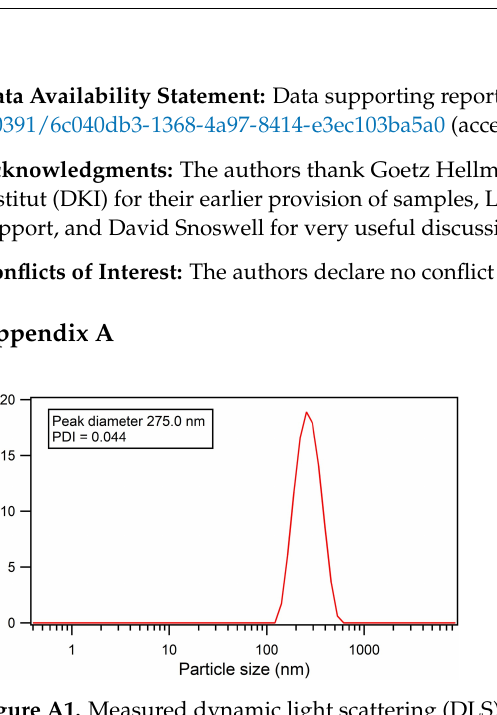
Figure A1. Measured dynamic light scattering (DLS) data for the polymer core–shell sample batch used experimentally, after particles had been redispersed into water at 25 ◦ C. The hydrodynamic diameter of particles showed a peak value of 275.0 nm (average value 256.2 nm), and a polydispersity index (PDI) value of